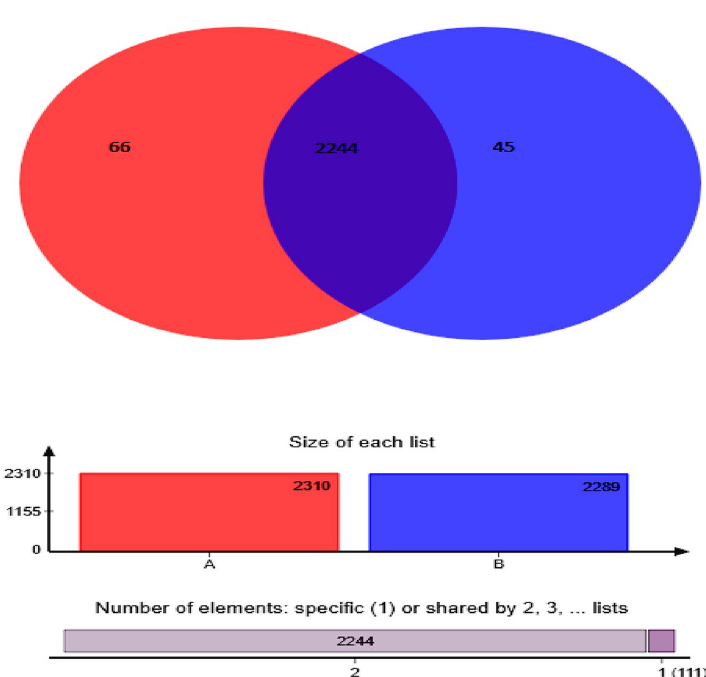
Figure 4. Distribution of bacterial OTUs in all soil samples showing in Venn diagram for Single plant is represented by (A) and interplant by (B). Overlapping area in Venn diagram represents the shared bacterial OTUs between single plant and interplant